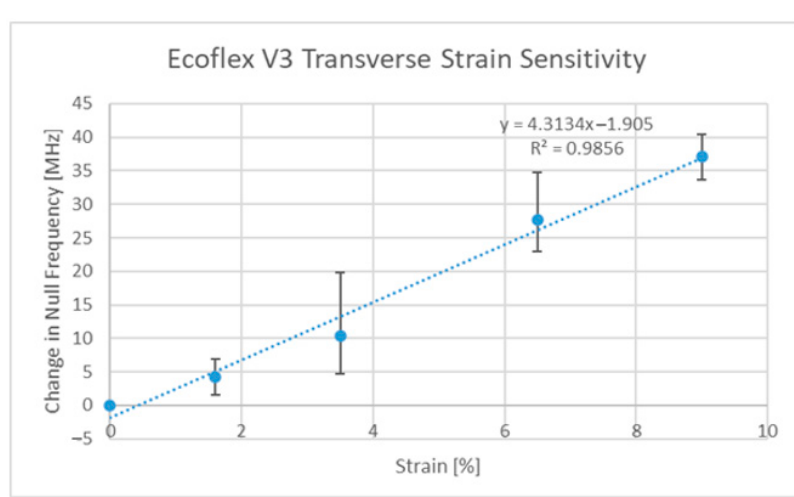
Figure 7. V3 axial strain sensitivity curve.